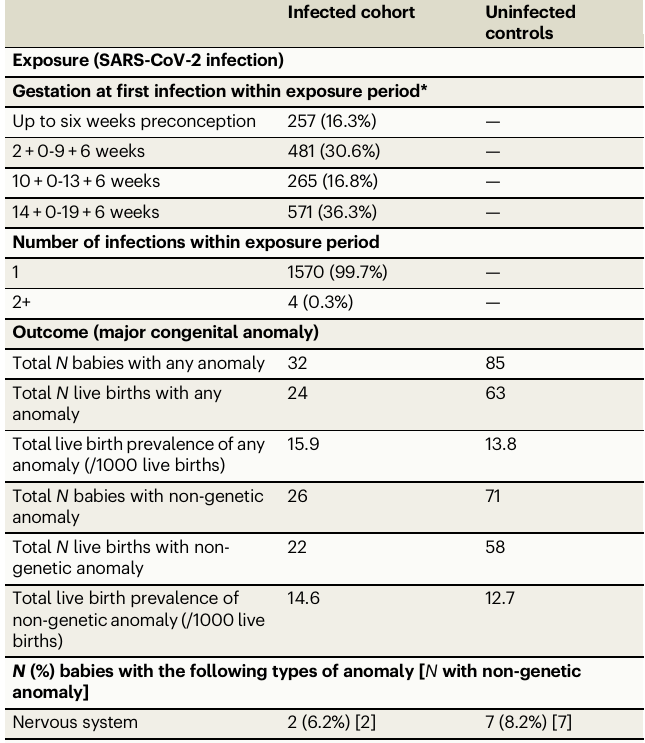
Table 5 | Descriptive information on infection exposure (infected group only) and on the risk and types of major congenital anomalies in the infected and controls